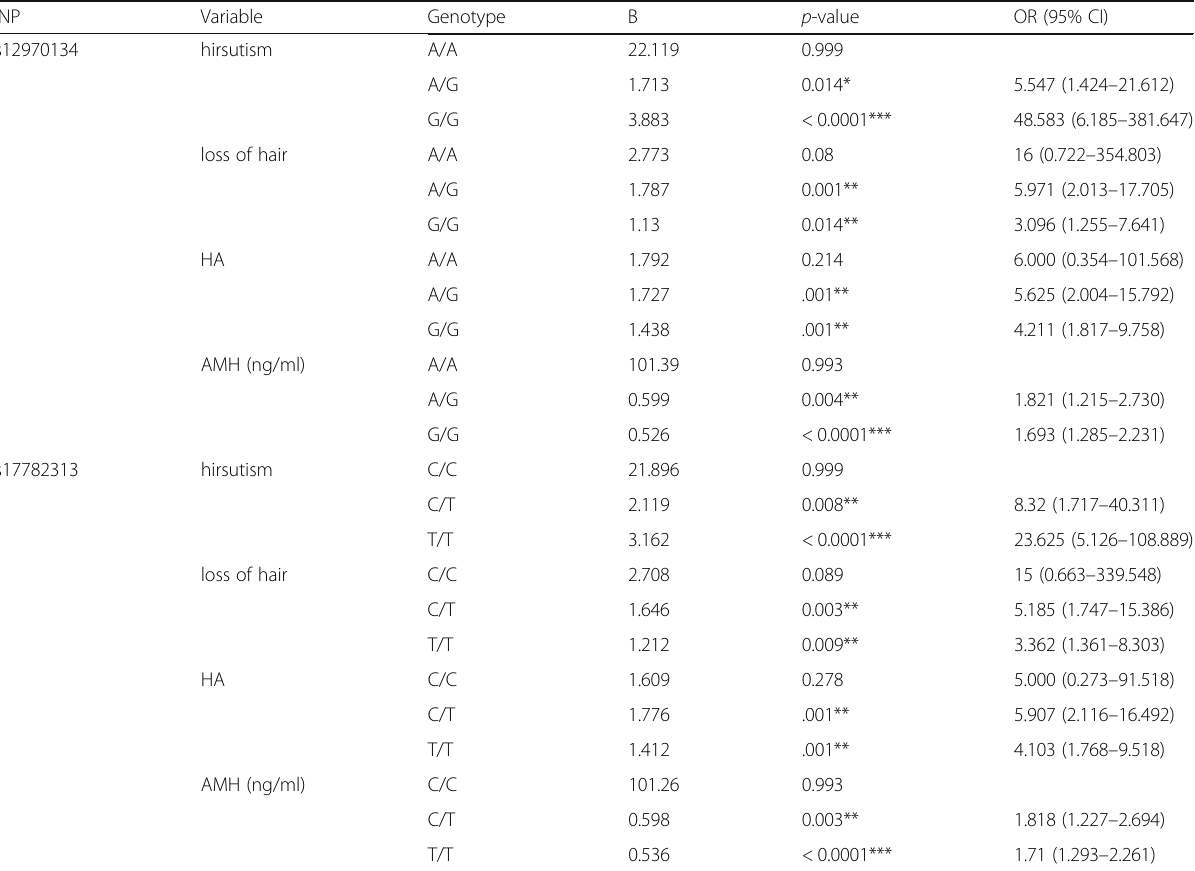
Table 5 The correlation of MC4R variants rs12970134 and rs17782313 with PCOS symptoms using binary logistic regression for patients with regard to